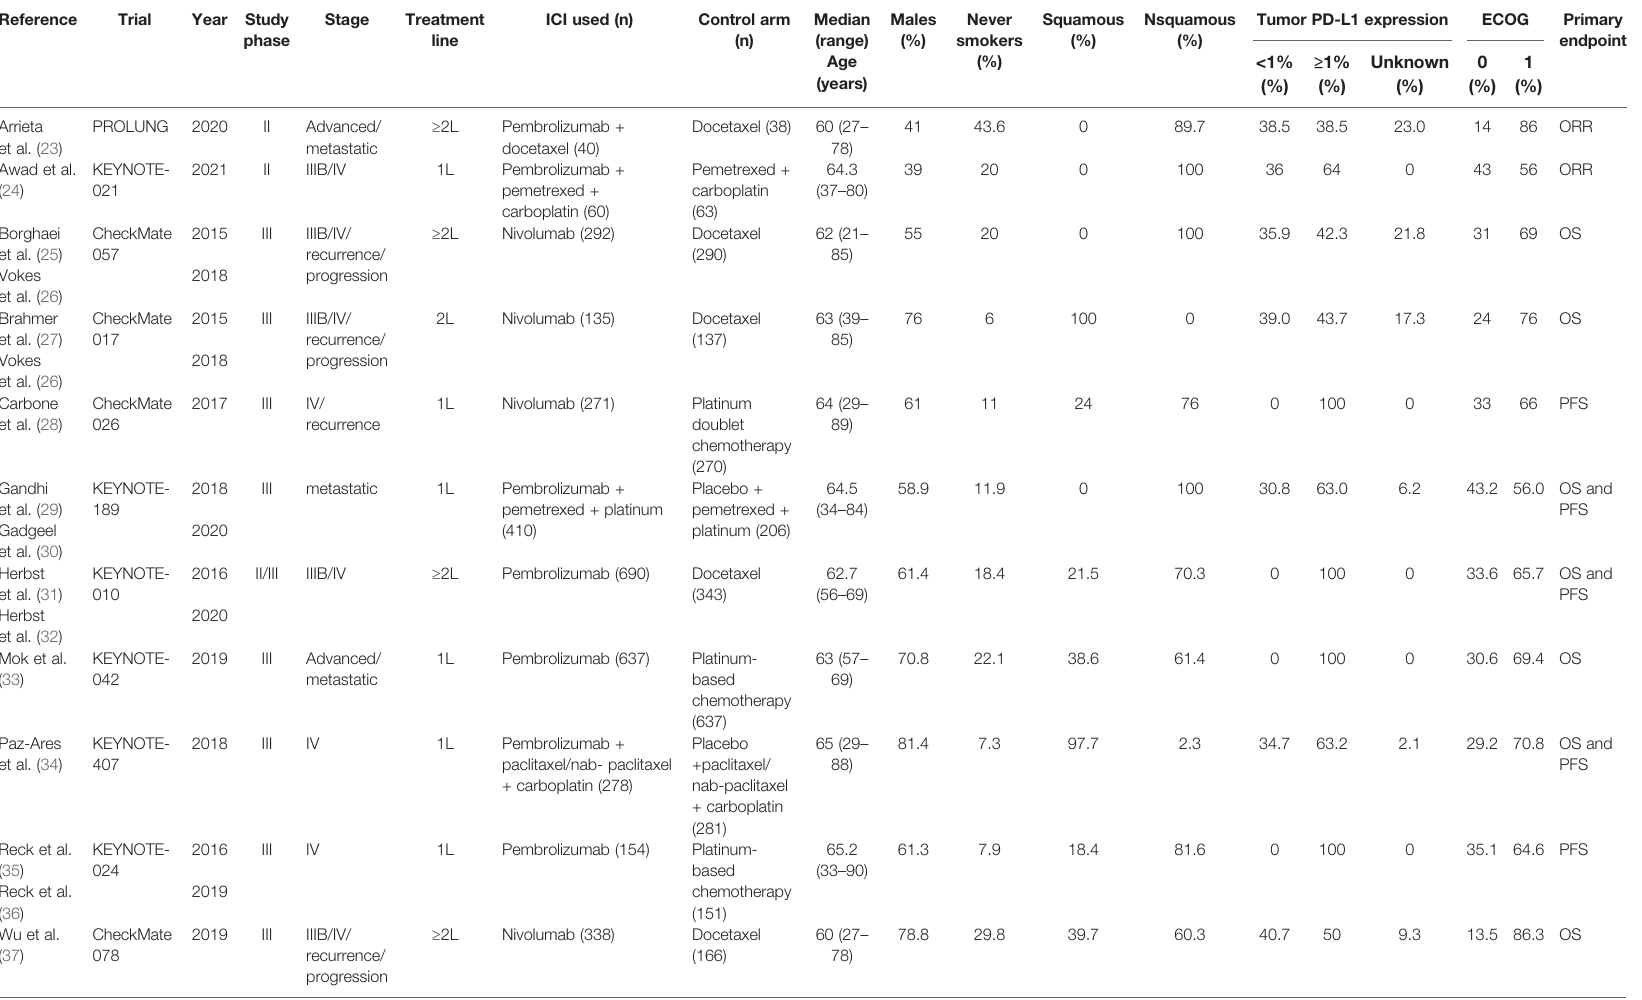
TABLE 1 | Basic characteristics of included